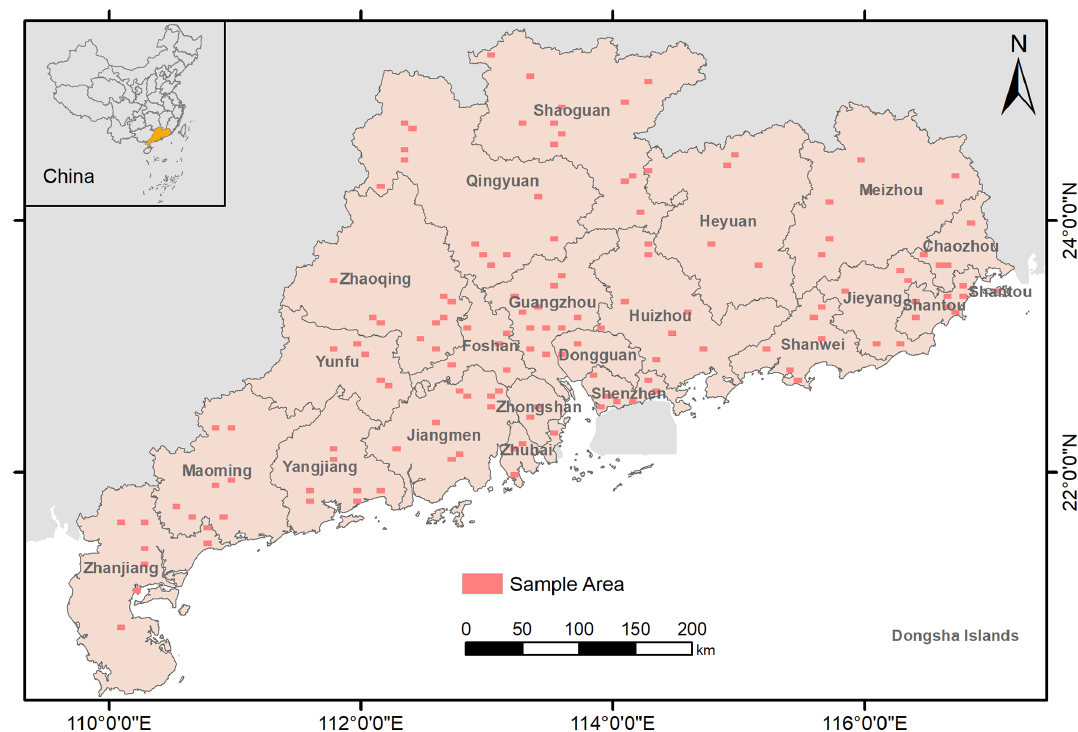
Figure 3. The 142 sample areas in UGSet collected from Guangdong Province, China. Each sample area has a data frame of 3 (cid:48) 45 (cid:48)(cid:48) in longitude and 2 (cid:48) 30 (cid:48)(cid:48) in latitude.